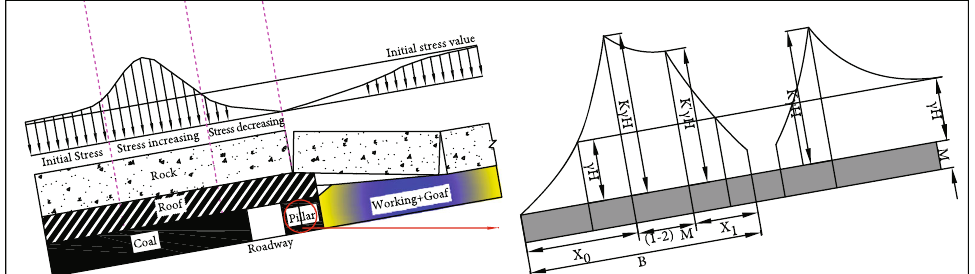
Figure 5: Elastic plastic deformation area and distribution of coal pillar stresses.